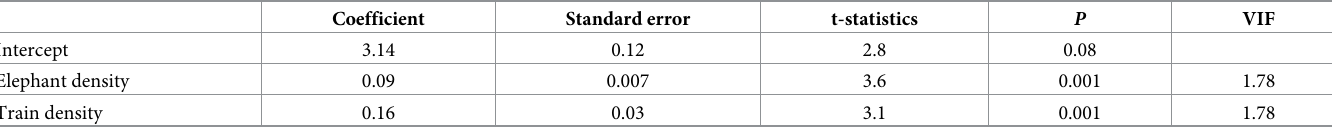
Table 6. OLS regression statistics showing the relative importance of predictor variables measured by the non-spatial coefficient values.